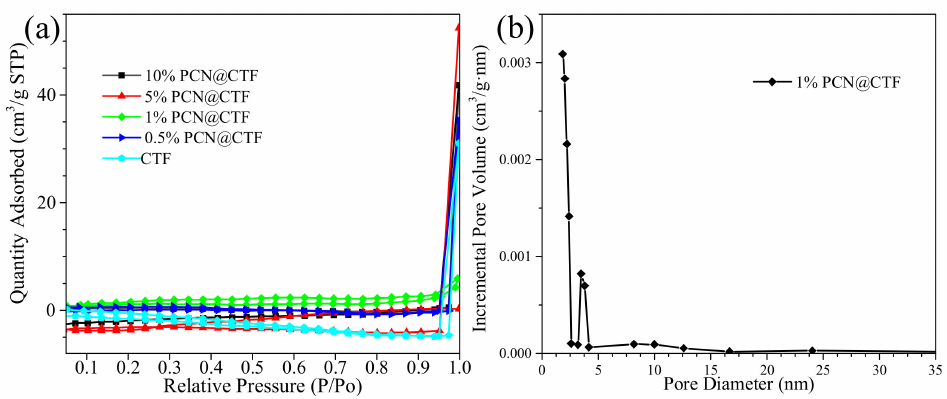
Figure 5. ( a ) N 2 adsorption/desorption isotherms (77 K) and ( b ) desorption pore size distribution plots of CTF and x %PCN@CTF.